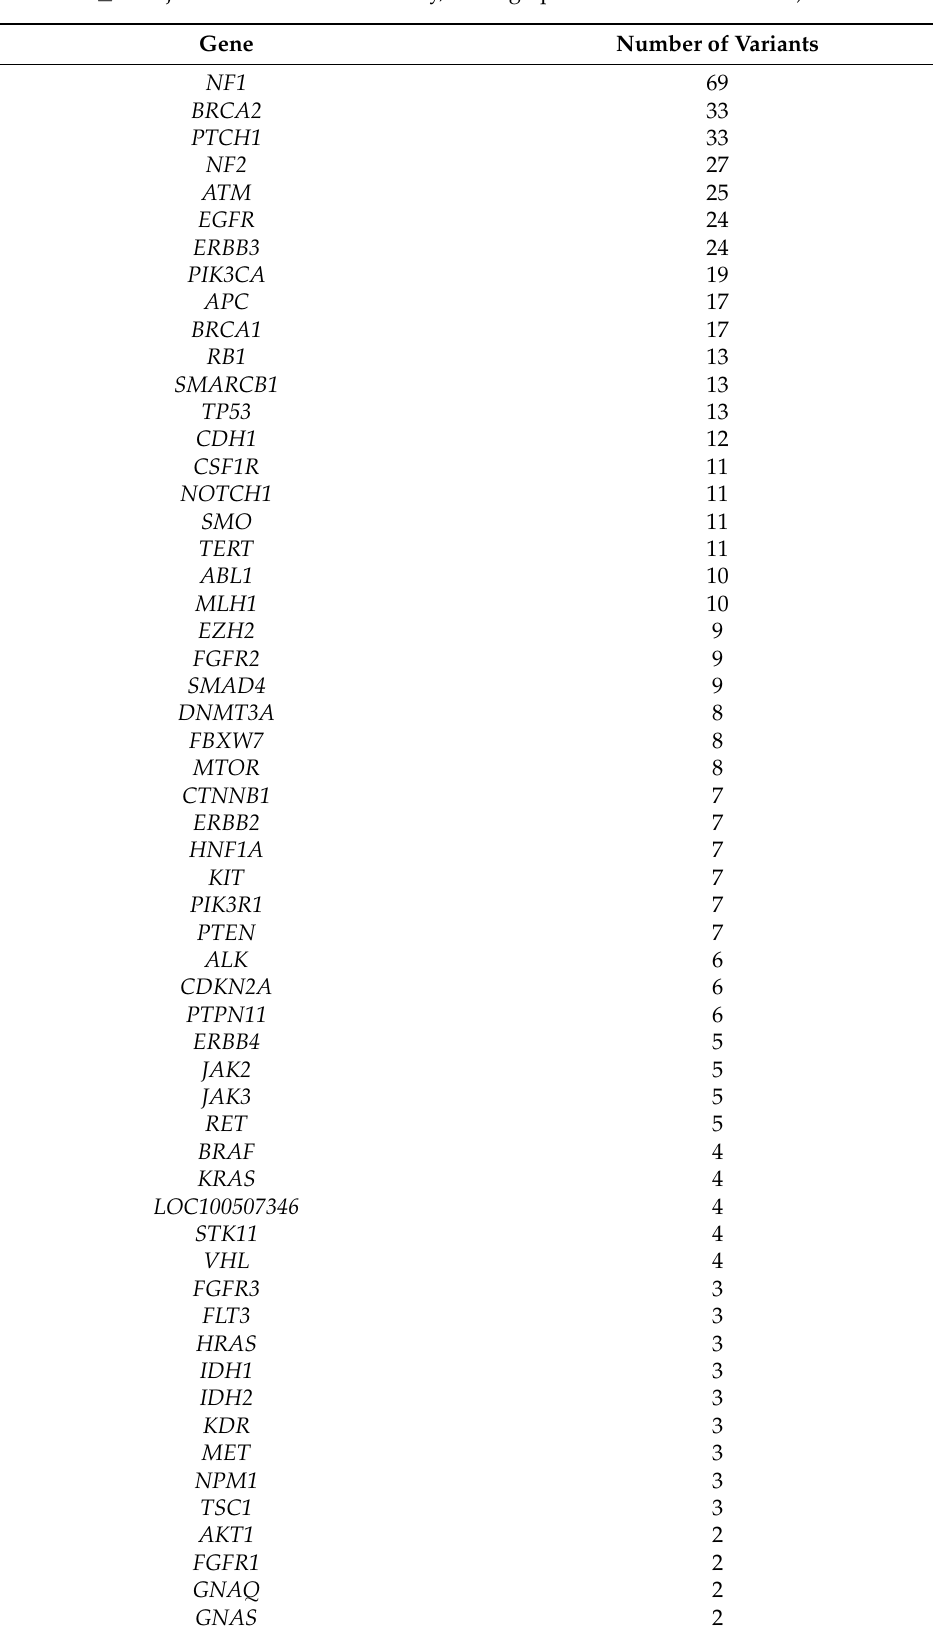
Table 4. Variants per oncogene/tumor-suppressor gene that were detected in all sequenced CTCs within a subject (total number of variants per gene were combined from all seven subjects; variants detected in ≥ 1 subject were counted once only, adding up to a total of 598